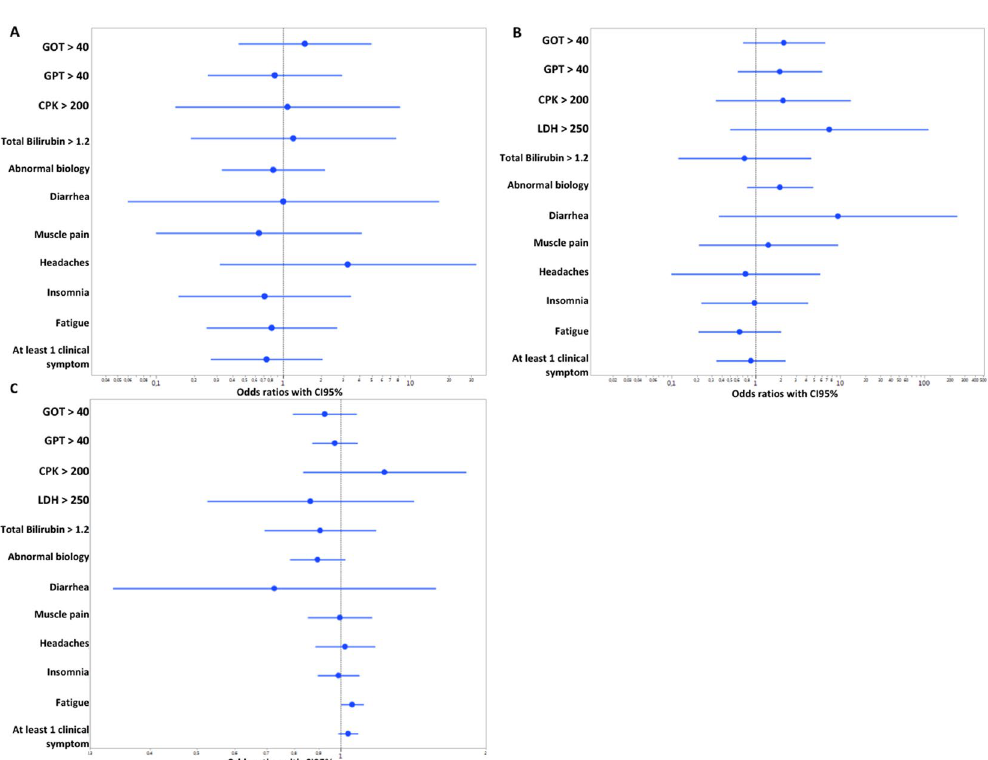
Figure 1. Forest plots displaying odds ratios (OR) with CI 95% for the risk of adverse drug reaction associated with ( A ) UGT1A1 * 28 allele carriership ( B ) an increment of 1 log 10 unit in plasma RAL concentrations, ( C ) an increment of 1 unit in the